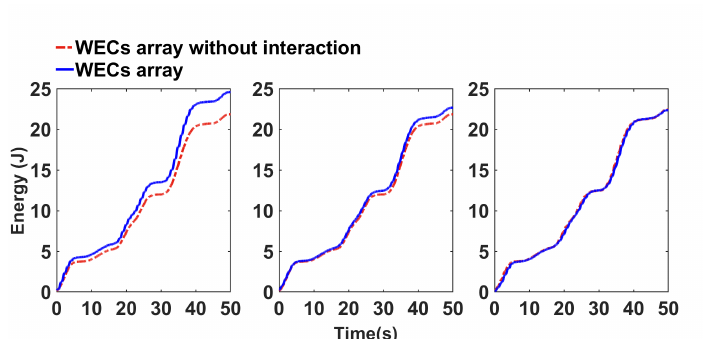
Figure 9. Electrical energy generated by the WEC array and WEC array without